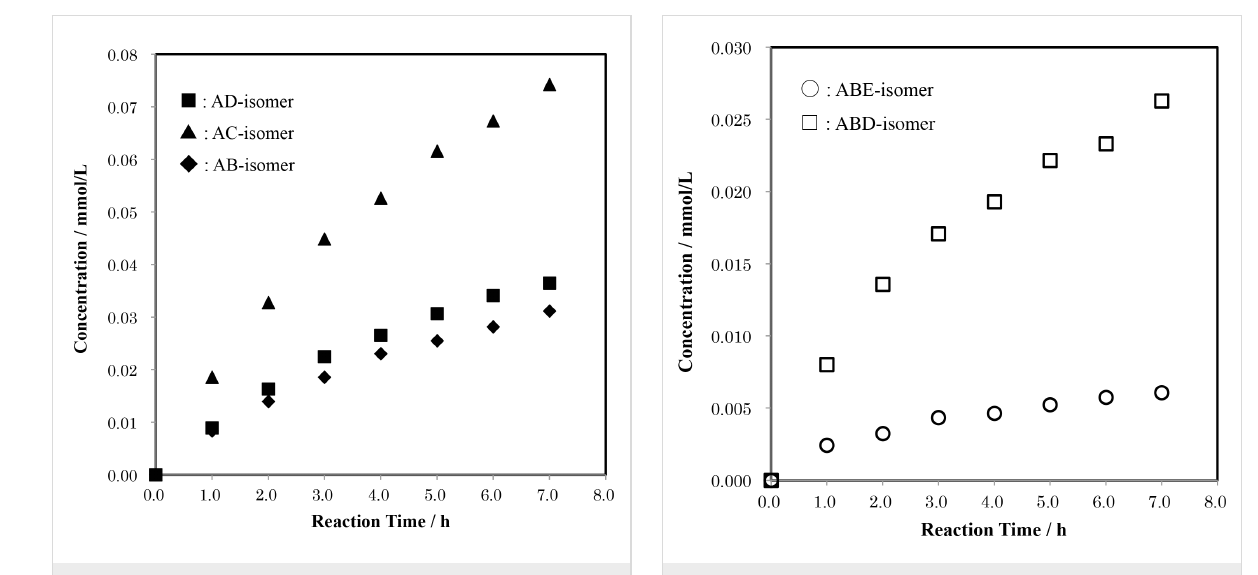
Figure 6: Time-course of the formation of the regioisomers of di-6- O - trityl- α -CD in a reaction of α -CD(Tr) 1 with TrCl in pyridine at 55 °C. Average mole ratios of AB:AC:AD = 0.43 ± 0.01:1.00:0.50 ± 0.01.